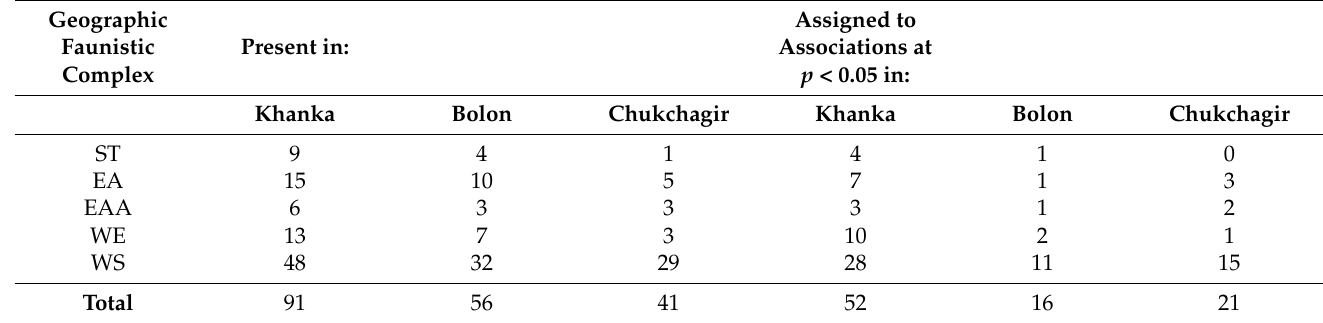
Table 2. The presence of taxa belonging to different geographic faunistic complexes in the three lakes and their assignment to associations at p <